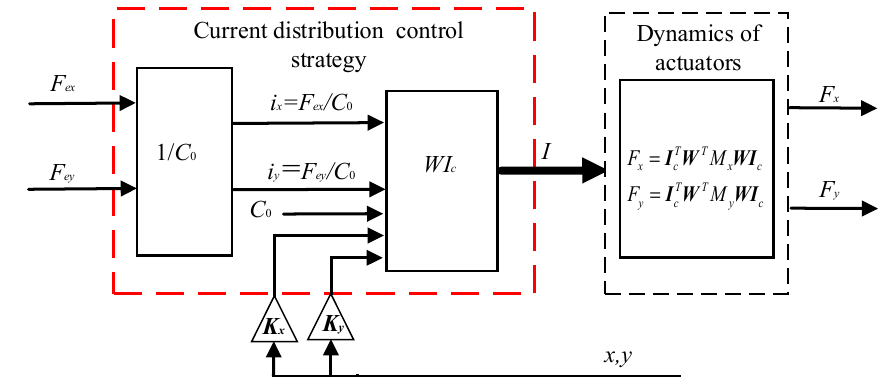
Figure 4. Curves of the relationship between F x and x that is illustrated in ( a ) and relationship between F y and y that is illustrated in ( b ).